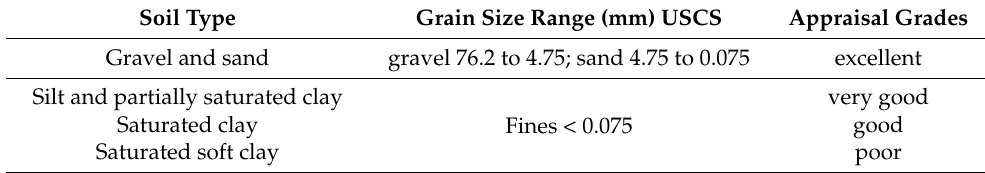
Table 3. Evaluation index of soil